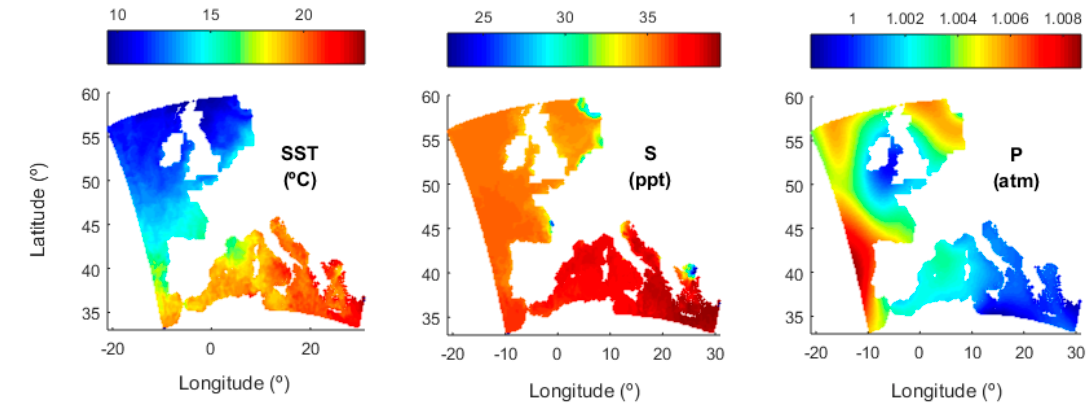
Figure 2. Sea surface temperature (SST), salinity (S) and air pressure (P) at the European coastal ocean from the 24 May 2014 at 06 h to the 27 May 2014 at 00 h. Each pixel corresponds to a square sided 11 km and averaged over the 66 h survey period.